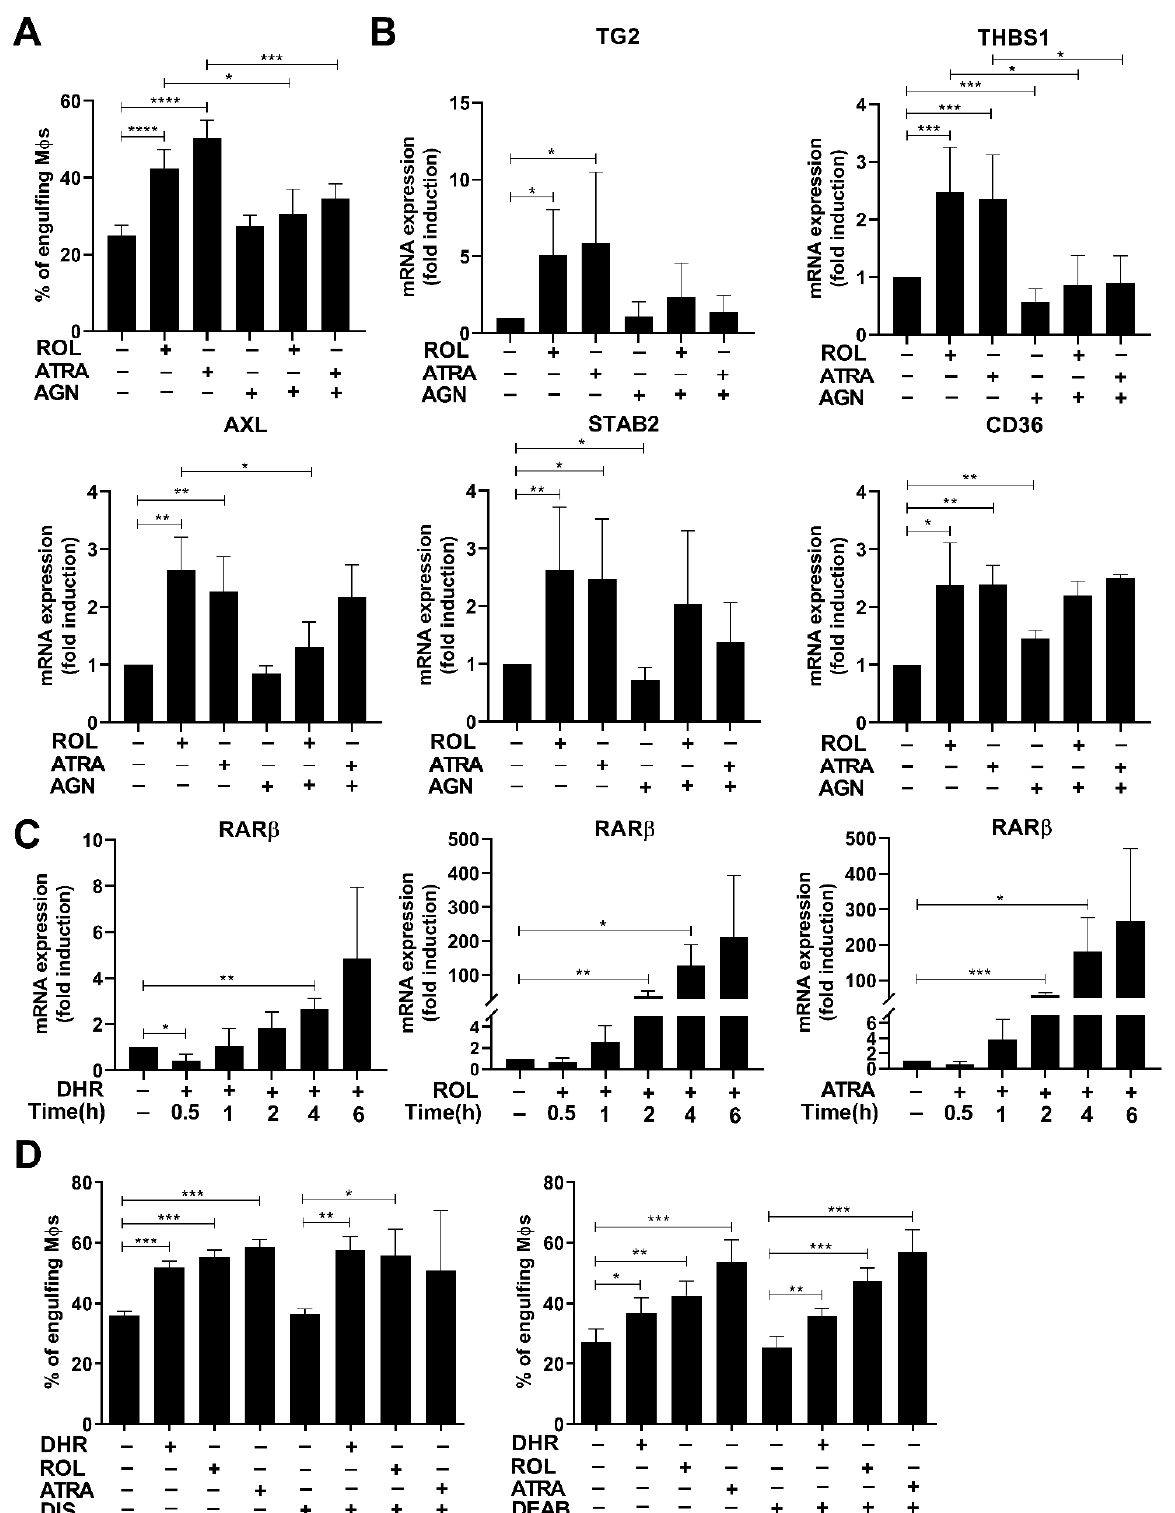
Figure 2. Both retinol and all- trans retinoic acid administered during the last two days of macrophage differentiation enhances efferocytosis of the resulting BMDMs by upregulating the expression of several efferocytosis-related molecules in a RAR-dependent manner. ( A ) Percentage of engulfing macrophages differentiated in the absence or presence of 1 µ M ROL or 30 nM ATRA alone or in the presence of 0.5 µ M AGN194310 administered during the last 2 days of their differentiation. ( B )